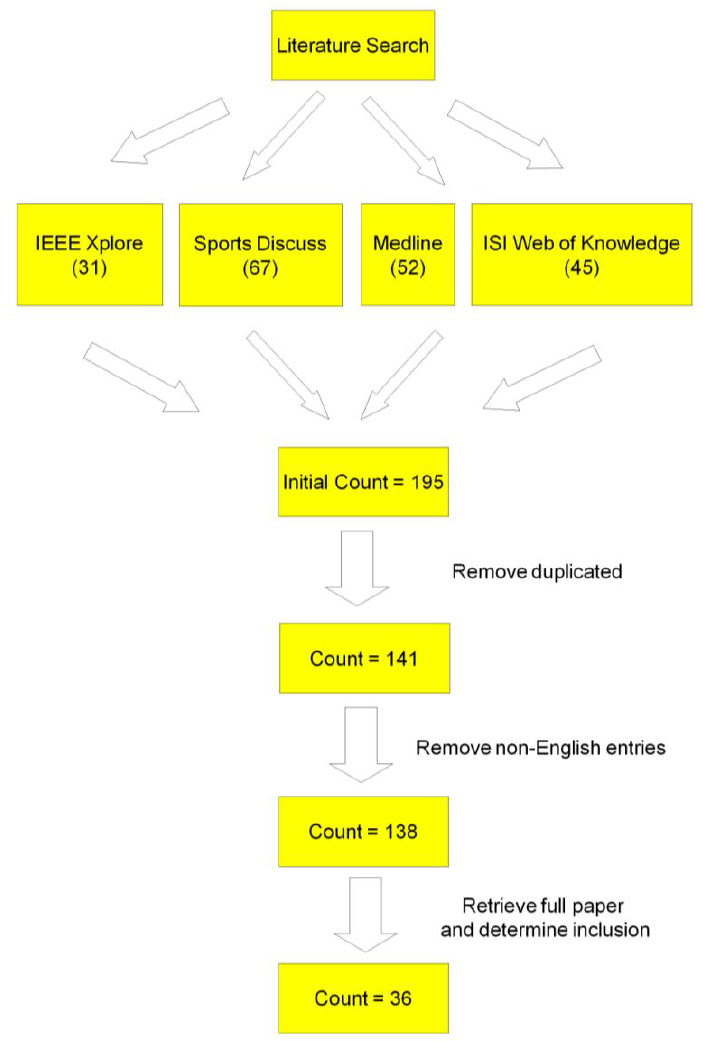
Figure 1. Research method of this